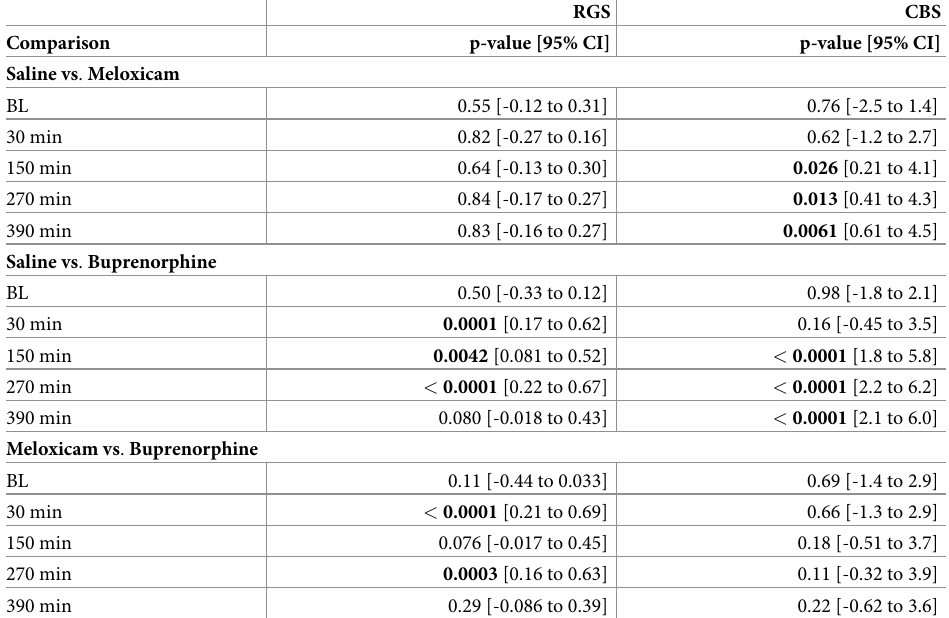
0.22 [-0.62 to 3.6]